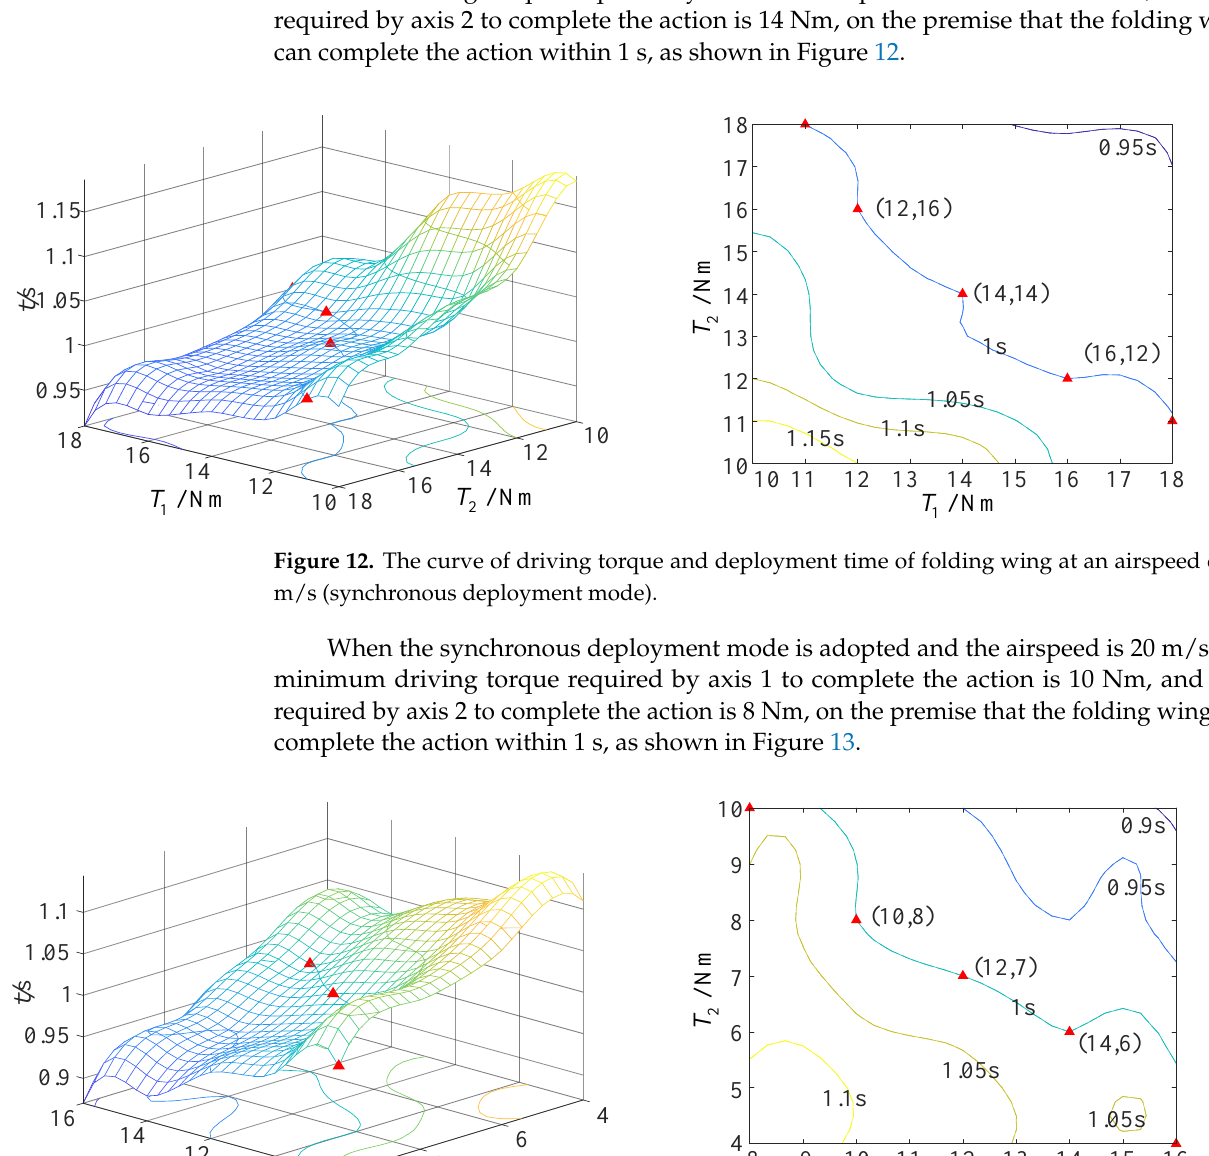
( c ) Figure 11. Fluent simulation process: ( a ) synchronous deployment process; ( b ) non-fixed-axis – fixed- axis stepwise deployment process; ( c ) fixed-axis – non-fixed-axis stepwise deployment process. 3. Results and Discussions 3.1. Aerodynamic Simulation of the Folding Wing under Different Airspeed and Deployment